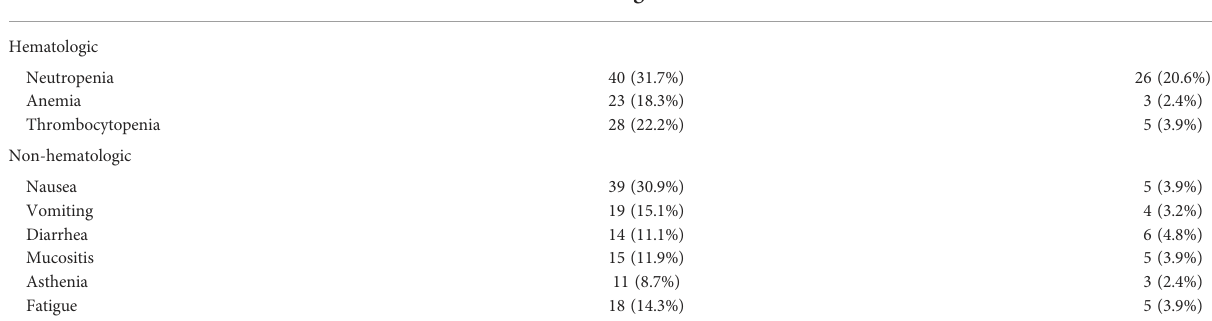
All grades Grade ≥ 3